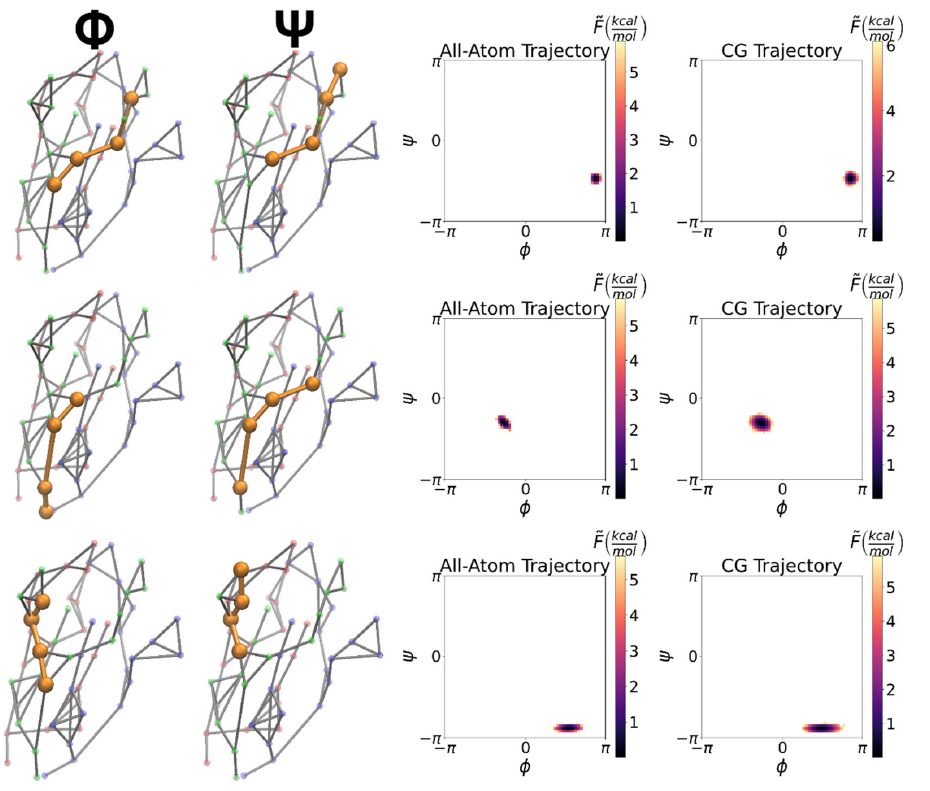
Figure 7. Free energy profiles of RBD pair (top), NTD pair (middle), and S2 subunit pair (bottom). Blue—chain A; red—chain B; green—chain C; orange—selected dihedral quadruplet.